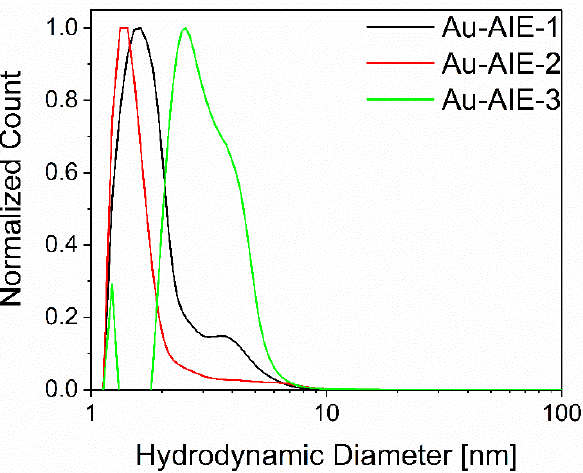
Figure 2. Normalized DCS number ‐ weighted particle size distributions of Au ‐ AIE nanoparticles, dispersed in water. The particles are well dispersed, with hydrodynamic diameters of 1.7 nm ( Au ‐ AIE ‐ 1 ), 1.4 nm ( Au ‐ AIE ‐ 2 ), and 3.2 nm ( Au ‐ AIE ‐ 3 ).